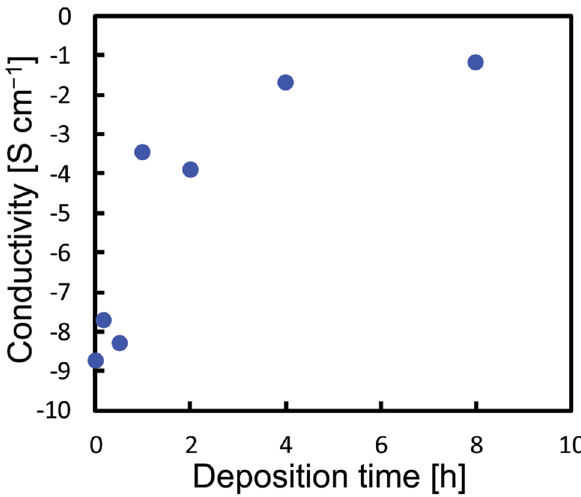
Figure 1. Electrical conductivity of the as-deposited BDND as a function of the CVD deposition time for the BDND